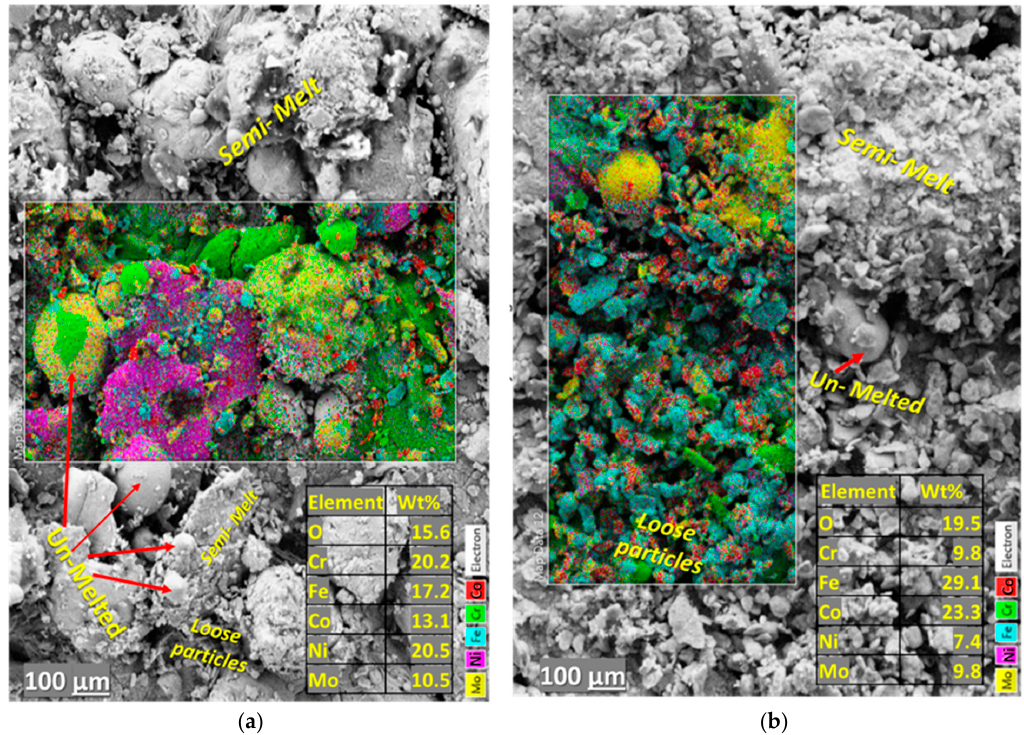
Figure 5. Top surface morphologies, elemental concentration and combined EDX surface map of the as-sprayed ( a ) LC-HEA_Mo 27 and ( b ) LC-HEA_Mo 20 coatings.